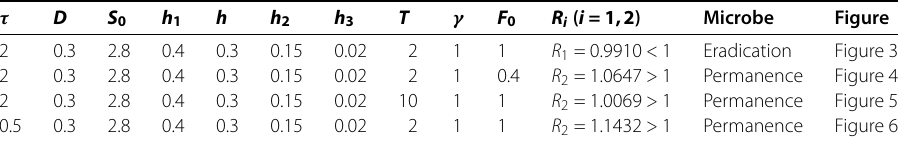
Table 1 Values of parameters, threshold and state of the